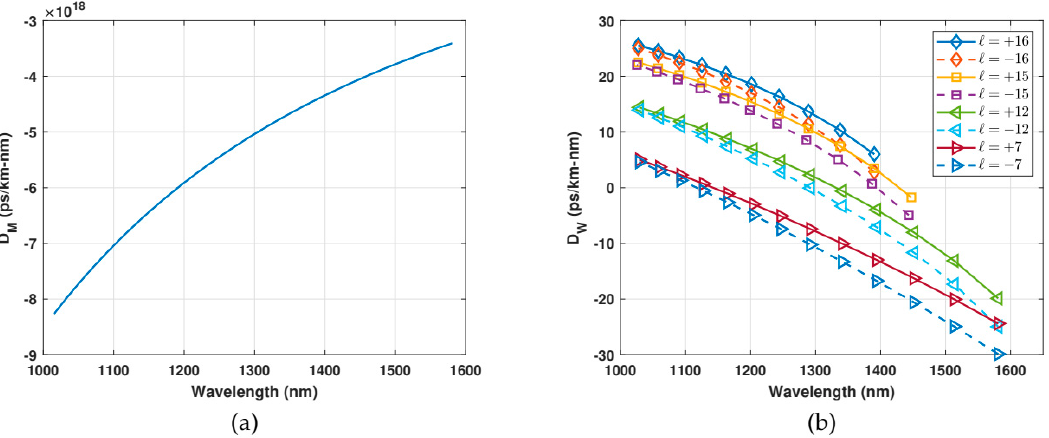
Figure 7. ( a ) Material dispersion. ( b ) Waveguide dispersion